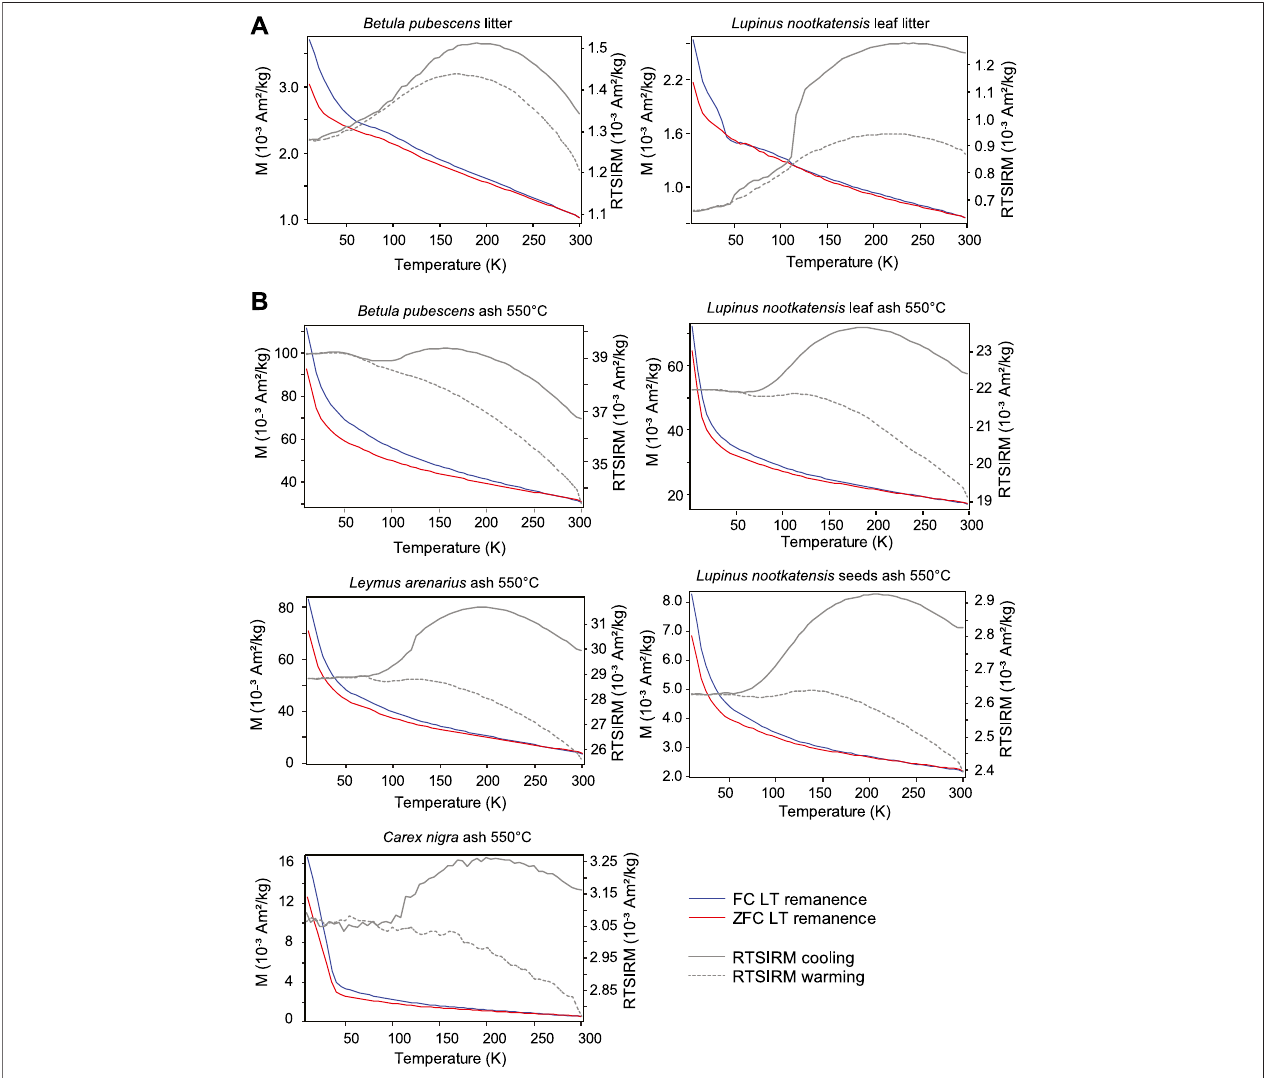
FIGURE 2 | Low-temperature remanence measurements after fi eld-cooling (FC) and zero- fi eld cooling (ZFC) along with cooling and warming curves of room- temperature remanence (right-hand scales) for (A) unheated Icelandic plant litter and (B) ashed Icelandic litter samples.